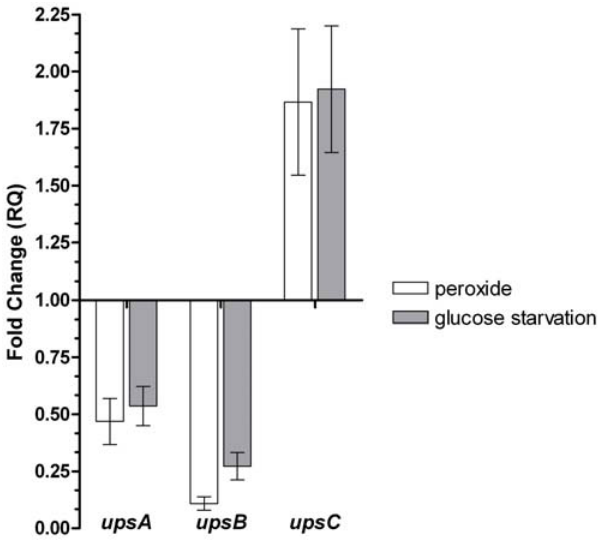
Figure 1. The relative change in expression of the upsA,B , and C var subtypes upon exposure to stress in NF-54 parasites. Synchronized ring stage parasites were exposed to a 4 hour pulse of stress inducing conditions (either 10 m M of tert -butylhydroperoxide or cultivation in the presence of 50% of the normal glucose concentra- tion). cDNA prepared from RNA isolated from these parasites was analyzed utilizing qPCR with ups -specific primers. Results are expressed as fold change in comparison to an unexposed control (Relative Quantification, RQ). Error bars represent mean 6 SEM.